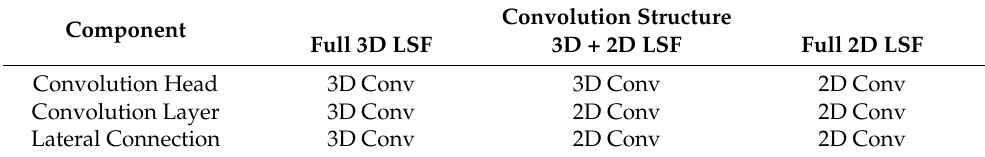
Table 1. The convolution structure of different components in the front end.